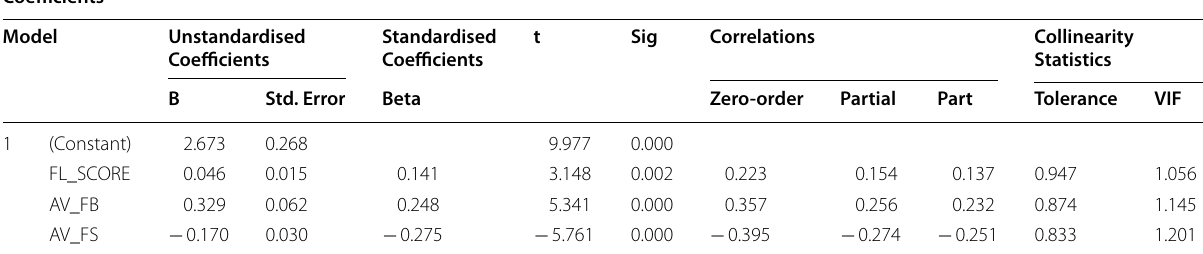
Table 11 Multicollinearity test